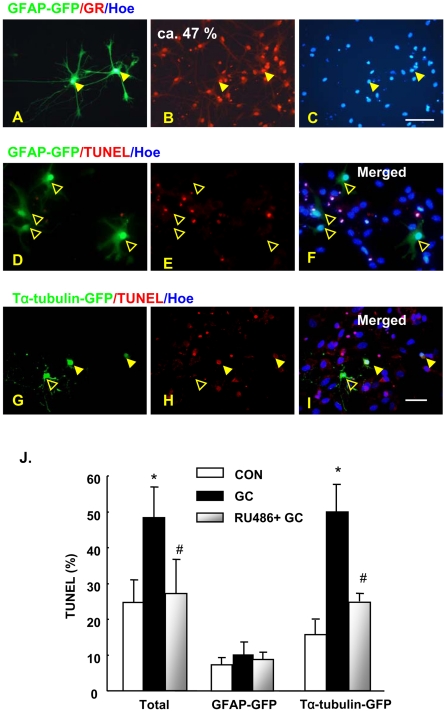
Astrocytes are spared from GC-triggered apoptosis in primary hippocampal cultures.Hippocampal cultures were genetically tagged with either Tα-tubulin-GFP or GFAP-GFP plasmids, to identify neurons and astrocytes, respectively. Approximately 50% of astrocytes in typical cultures displayed GR immunoreactivity (A–C, examples shown by arrowheads). After exposure to GC or vehicle, apoptosis in the different cell populations was visualized by TUNEL and Hoechst 33342 histochemistry (D–F and G–I). Solid arrowheads exemplify GFP+ cells that entered apoptosis after GC treatment; open arrowheads indicate non-apoptotic GFP-transfected cells. Numerical data (mean ± SD) from analysis of TUNEL staining in either all cells in culture, Tα-tubulin-GFP or GFAP-GFAP sub-populations are depicted in (J). * p<0.05 vs. CON, # p<0.05 vs. DEX. Scale bars: 50 µm in A–C and 20 µm in D–I.